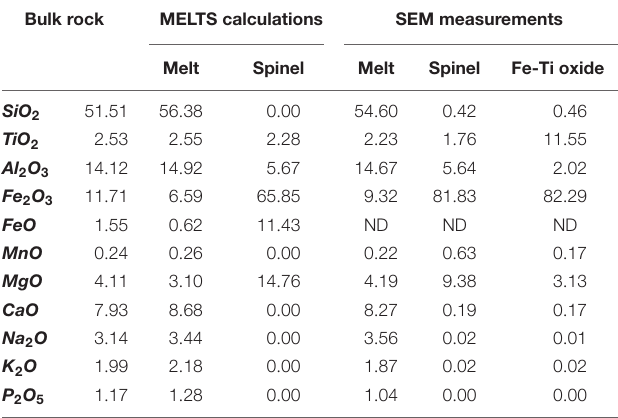
TABLE 1 | Composition of the crystals and the residual melt of the Lovejoy basalt modeled by MELTS (Gualda et al., 2012) and measured by Secondary Electron Microprobe (SEM).